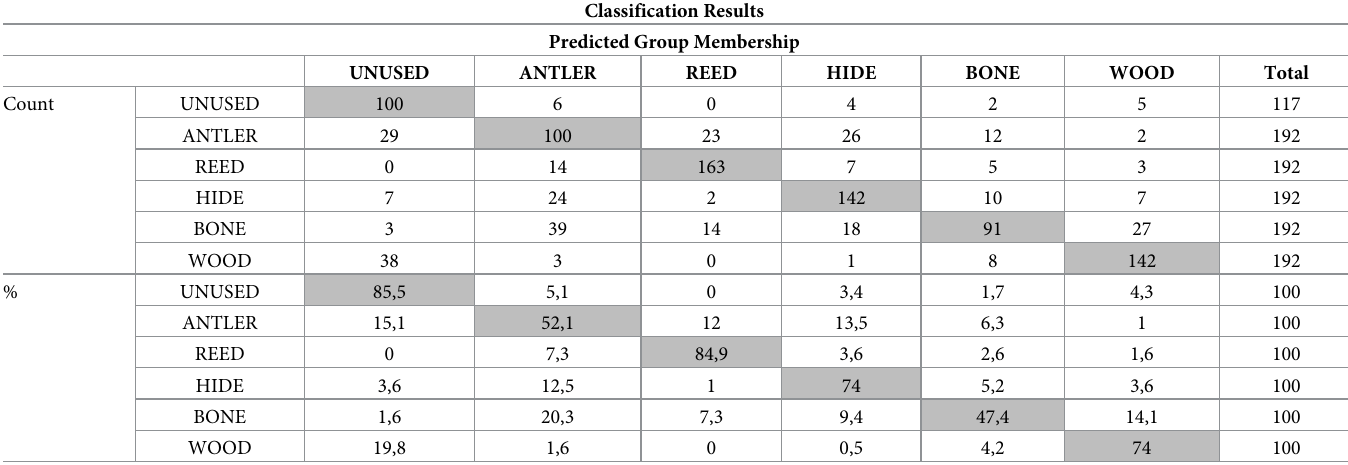
Table 4. Results of classification of the five worked materials (antler, reed, hide, bone and wood) and no use by quadratic discriminant analysis. 68.5% of original grouped cases were correctly classified. Shaded cells indicate the correct